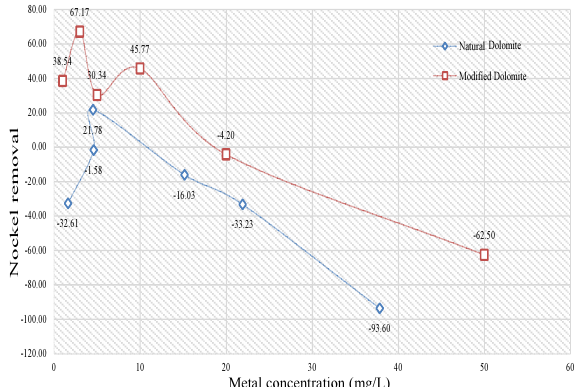
Fig. 14. Comparison of the removal of nickel (%) from the solution in certain concentrations by 0.75 g of modified and natural dolomite within a 30 minute contact